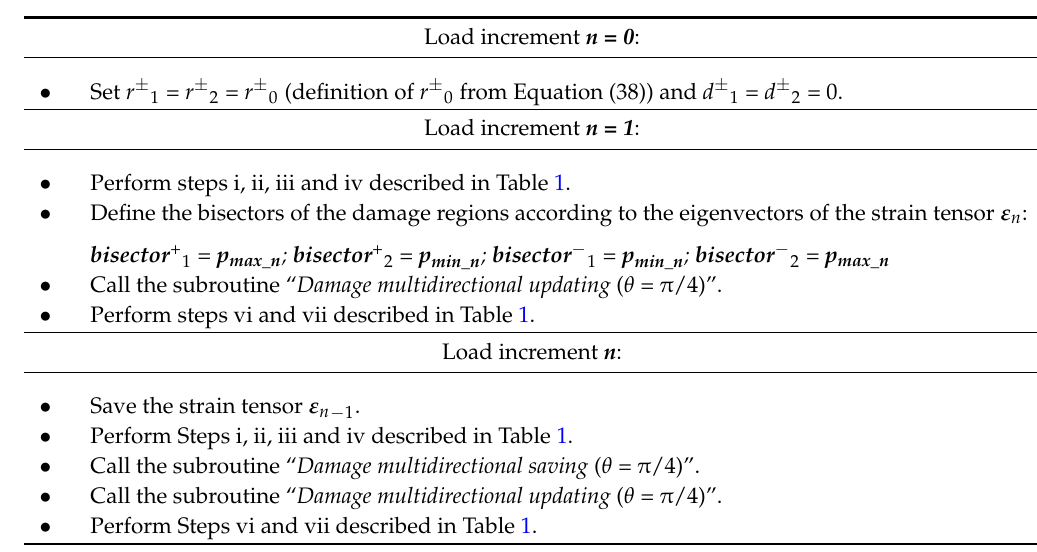
Table 2. Algorithm for the multidirectional d + /d − damage model, Type Load